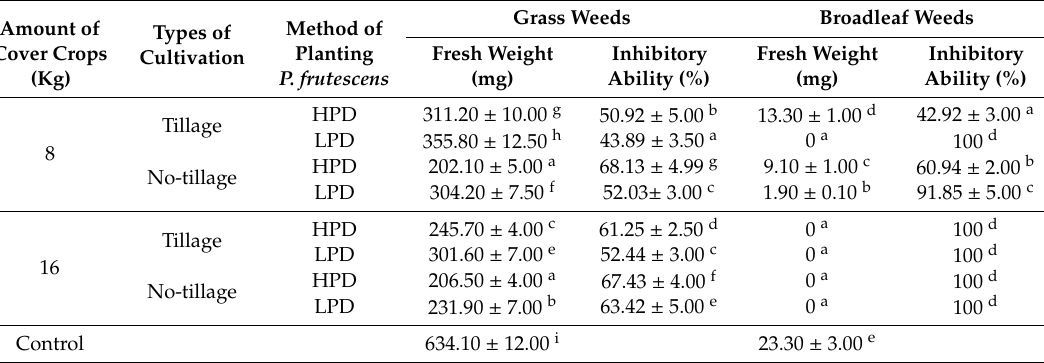
Table 5. E ff ect of seeding density of Paldong cv., tillage, and no-tillage on weed control. Amount of Cover